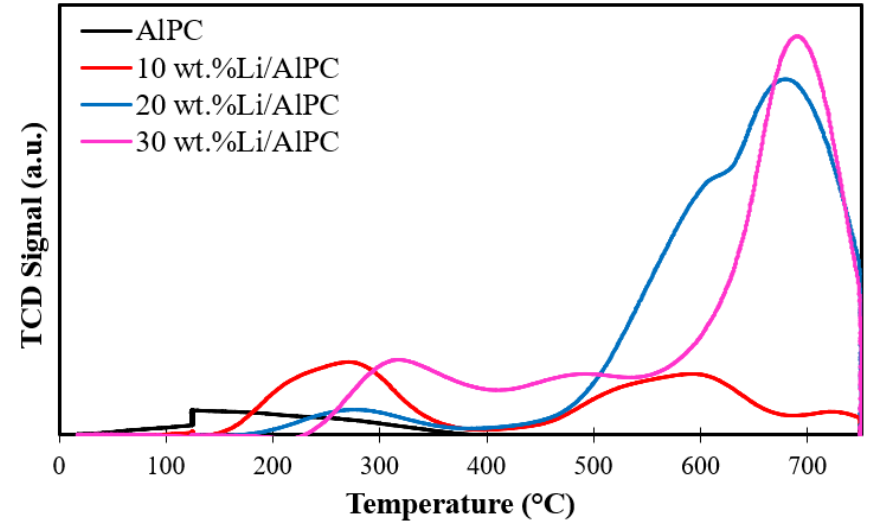
Figure 5 . NH 3 -TPD profiles of AlPC and x wt.%Li/AlPC ( x = 10, 20, and 30 wt.%) catalysts . Figure 5. NH 3 -TPD profiles of AlPC and x wt. %Li / AlPC ( x = 10, 20, and 30 wt. %) catalysts. Table 2. The total concentration of acidity and basicity in calcined Li / AlPC sample. Table 2. The total concentration of acidity and basicity in calcined Li/AlPC sample. Sample